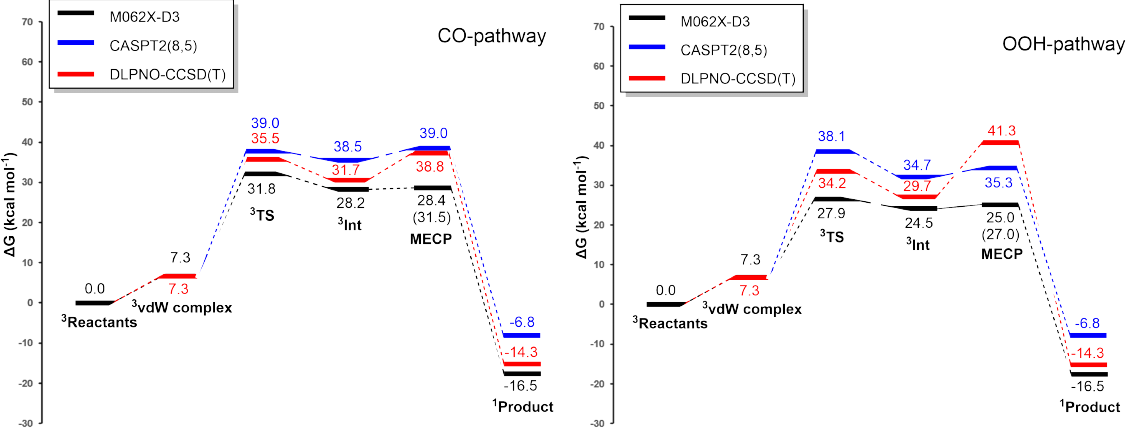
Figure 7. Free energy profile for the addition of O 2 to 2-methyl-3,4-dihydro-1-naphthol along the two possible reaction paths for M062X-D3, CASPT2(8,5), and DLPNO-CCSD(T). M062X-D3 and DLPNO-CCSD(T) single-points with maug-cc-pVTZ basis set over maug-cc-pVDZ geometries and vibrational analysis in acetonitrile implicit solvent (SMD) level of theory. CASPT2 single-points with maug-cc-pVDZ basis set. Each structure was optimized for the lowest spin state. At MECP, the increase in free energy caused by the limited hopping probability is shown in parentheses. Left panel: CO − pathway. Right panel: OOH-pathway. Energies (in kcal/mol) refer to the reactants’ asymptote where the two reactants are separated. Energies correspond to the ground state for each geometry. Energies for triplet and singlet states are shown in Figure